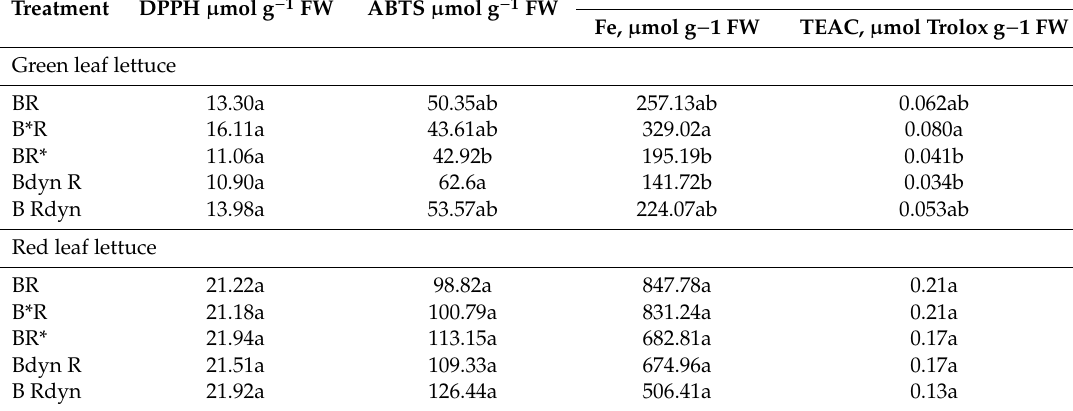
Table 3. The antioxidant properties of red and green lettuce leaves, illuminated with constant and dynamic intensities of red 662 nm and blue 452 nm light. Different letters indicate statistically significant differences between means according to the Duncan’s multiple range test at the confidence level p = 0.05.